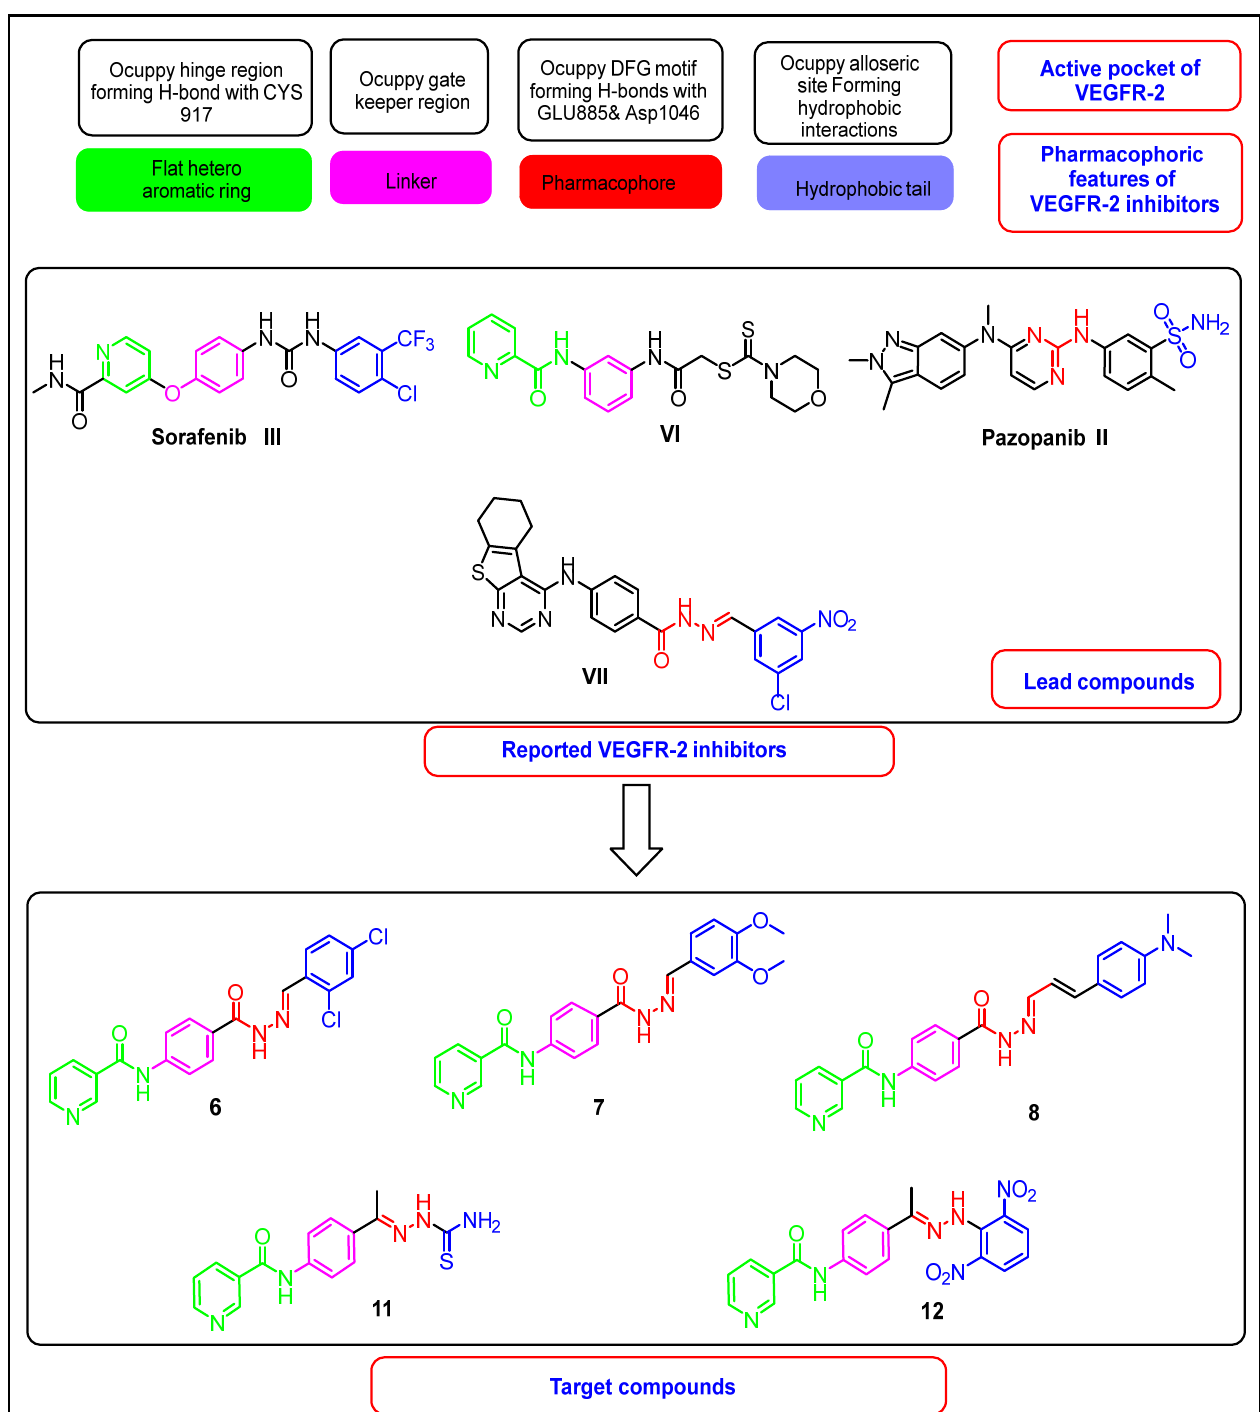
Figure 2. The design rationale of the targeted compounds.